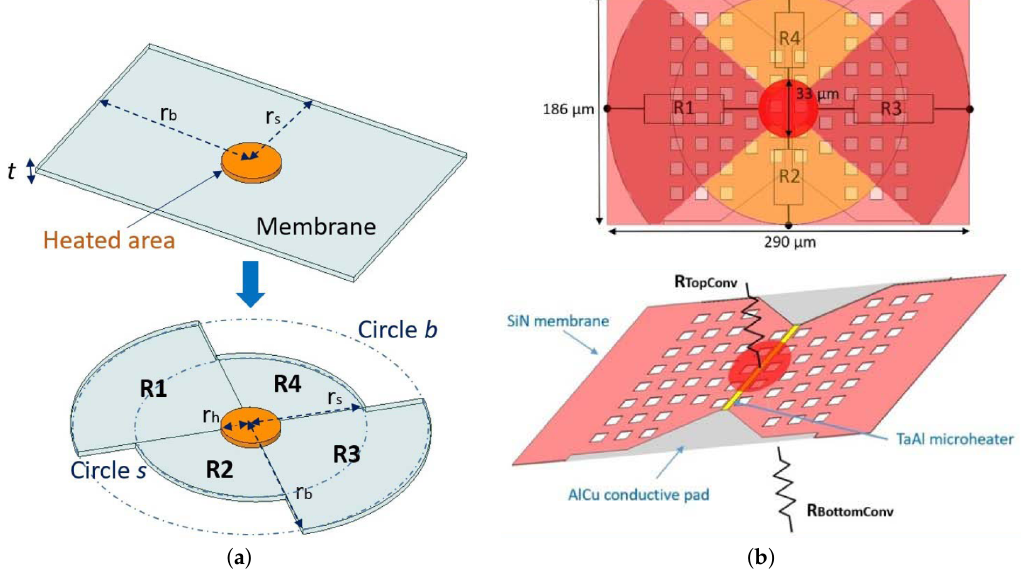
Figure 13. Sensor geometry from [17] used to test the Cauer network model. In ( a ) the geometry used when considering heat loss by conduction is shown, while in ( b ) the treatment of the heat loss mechanism by convection is depicted on the bottom and the membrane size and extracted thermal resistances are shown on